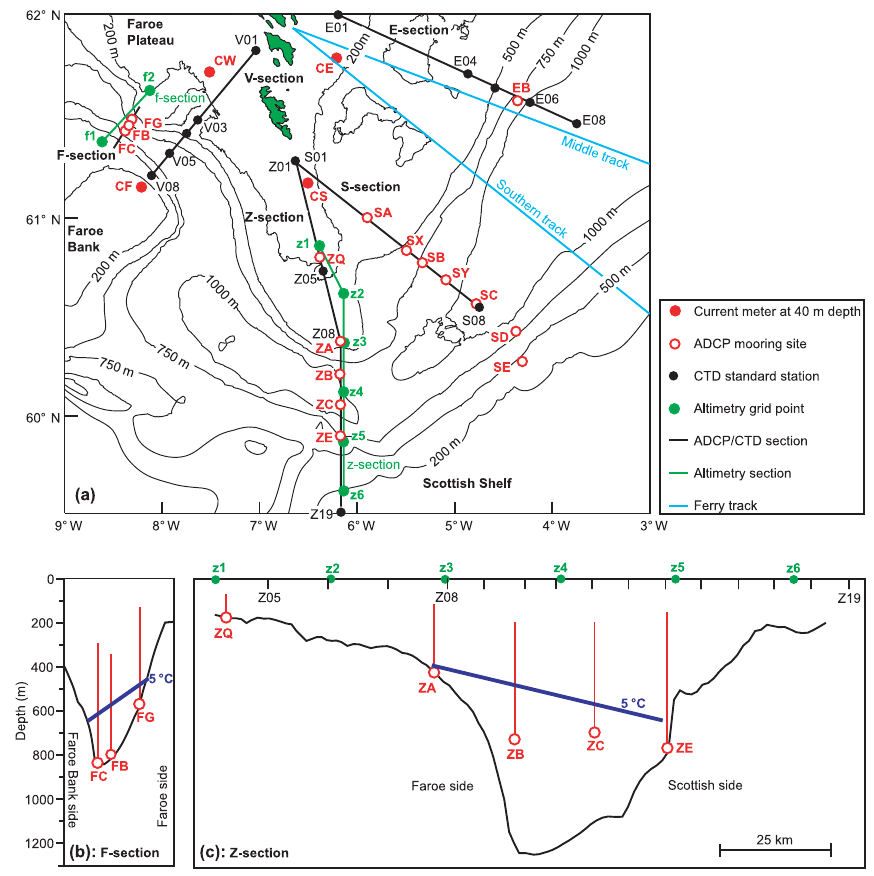
Figure 2. Locations of observational data: map view (a) and cross-section views of (b) the F-section and (c) the Z-section. Vertical red lines on the cross sections indicate range of 100% good daily averaged ADCP data. Blue lines indicate the average depths of the 5 ◦ C isotherms on the sections (from Hansen and Østerhus, 2007; Hansen et al., 2013). ADCP sites and CTD stations are labelled with uppercase letters, whereas altimetry grid points are labelled with lowercase letters. The two cross sections are drawn in the same vertical and horizontal